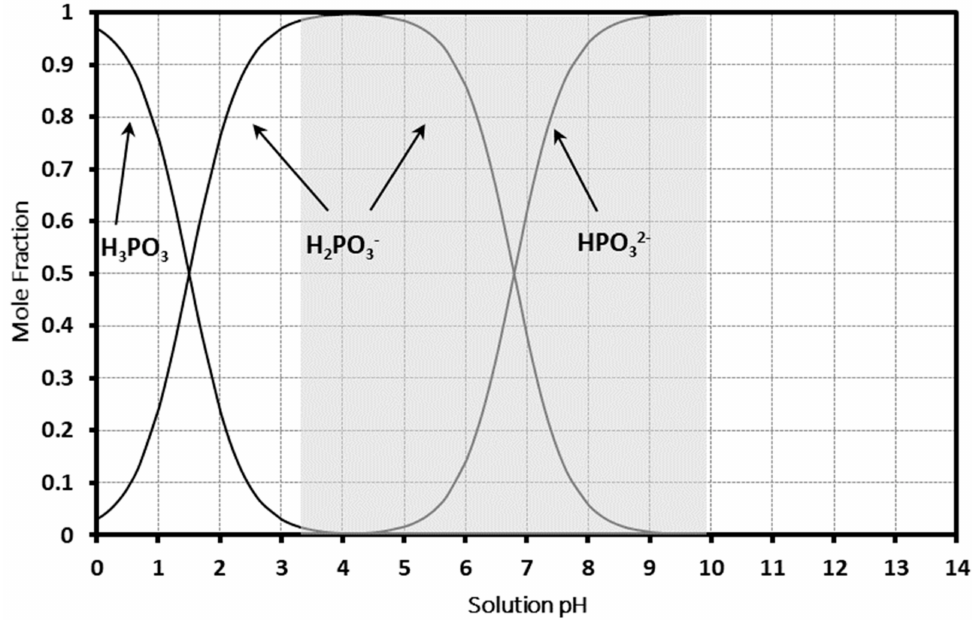
Figure 3. Distribution of phosphite species in water as influenced by pH. Shaded area represents normal range in soil pH.